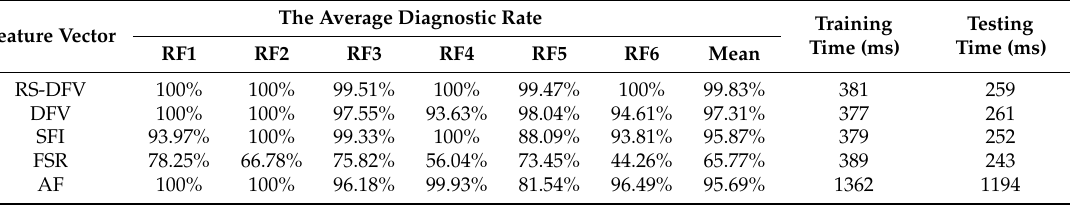
Table 11. Comparison with other feature vectors.